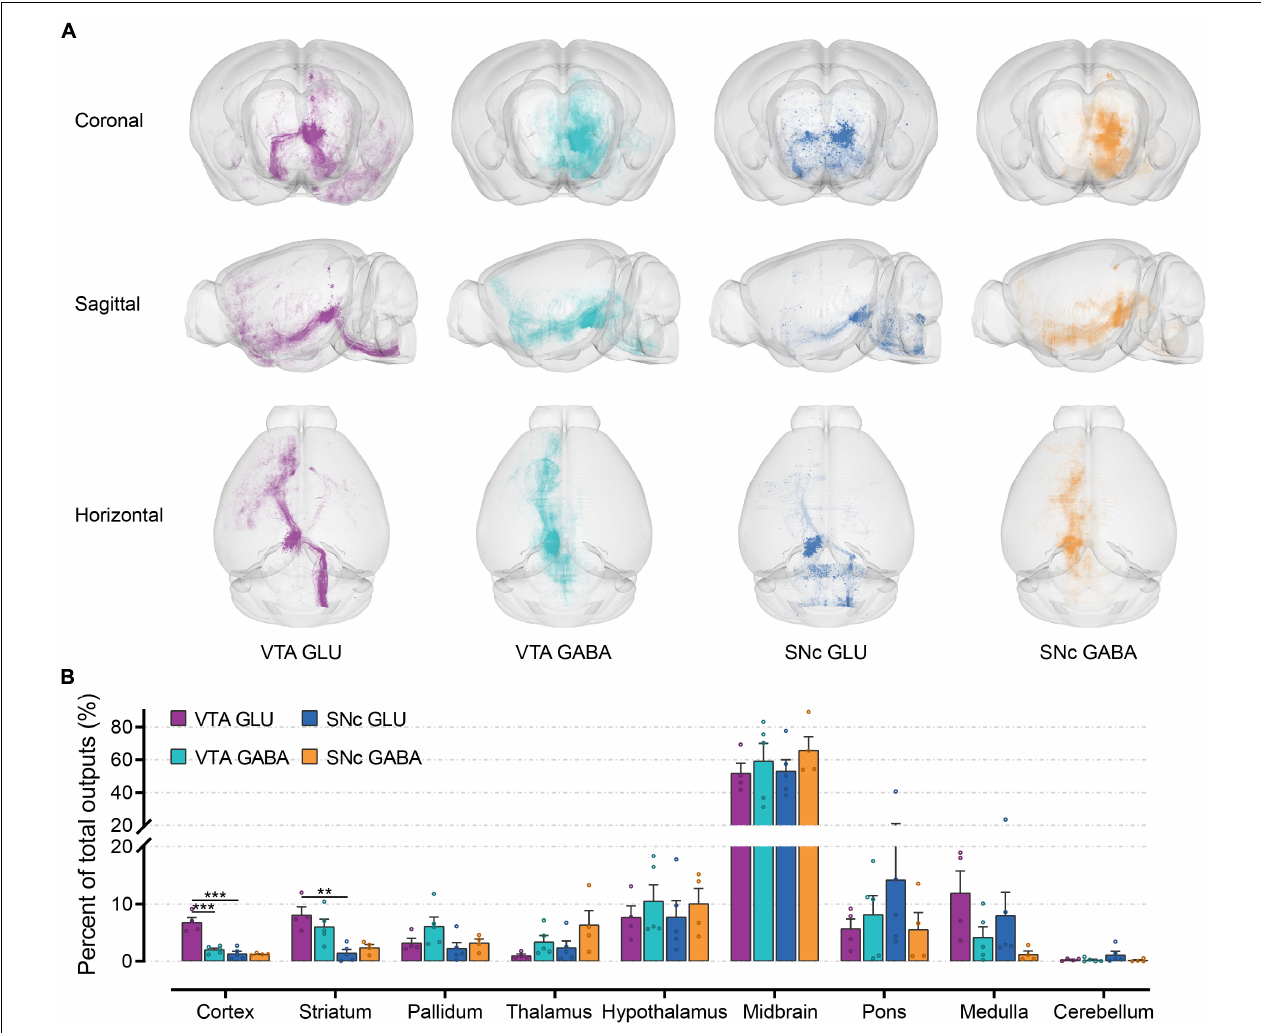
FIGURE 5 | Whole-brain outputs of glutamatergic and GABAergic neurons in VTA and SNc. (A) 3D visualization of whole-brain output projections of the glutamatergic and GABAergic neurons in VTA and SNc from different view. (B) Proportions of output projections from nine brain areas. Mean ± SEM ( n = 5 mice each for the VTA GABA and SNc GLU groups, n = 4 mice for the VTA GLU and SNc GABA). *** p < 0.001 and ** p < 0.01. Only significant differences between the same cell type in different brain areas or between cell types in the same brain areas are marked; one-way ANOVA with Bonferroni correction. The percentages of outputs in nine brain areas are listed in Supplementary Data 2